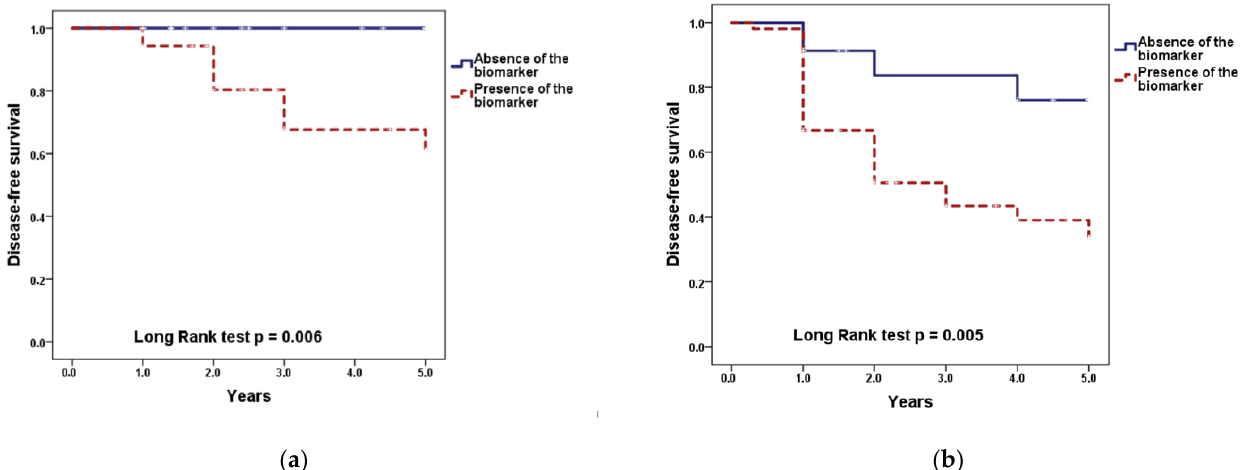
Figure 5. Disease free survival of CC patients with stages II ( a ) and III ( b ) depending on the absence/presence of the biomarker (HPV-negativity or integration of HPV16/18 DNA into the cell genome).